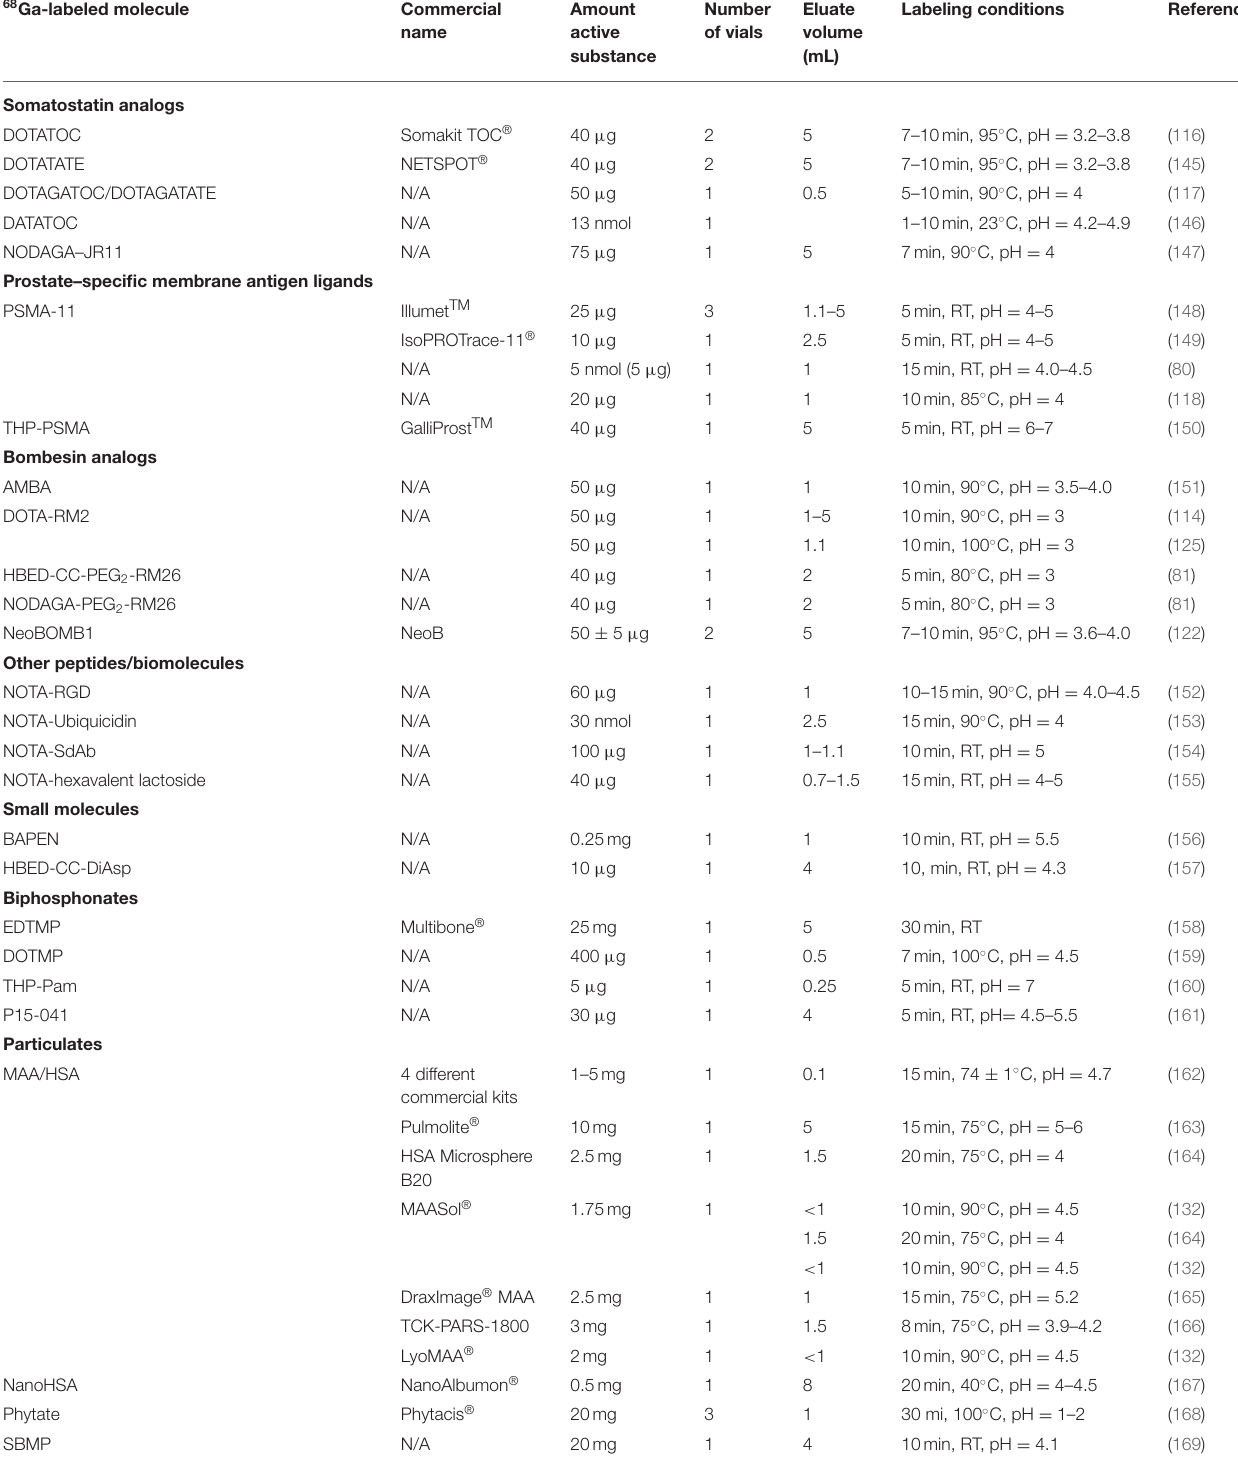
TABLE 1 | Overviewof cold kits reported in the literature for the preparation of gallium-68 ( 68 Ga) imaging agents. 68 Ga-labeled